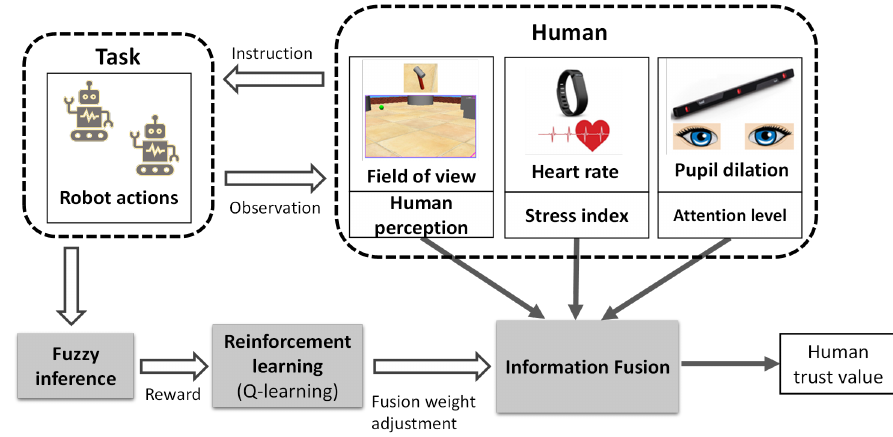
Figure 1. Structure of the proposed